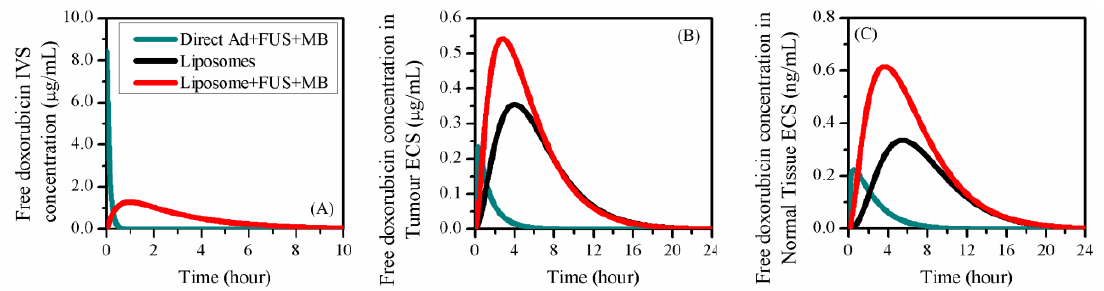
Figure 6. The time course of free doxorubicin concentration under di ff erent delivery modes. ( A ) IVS, ( B ) tumour ECS and ( C ) normal tissue ECS.